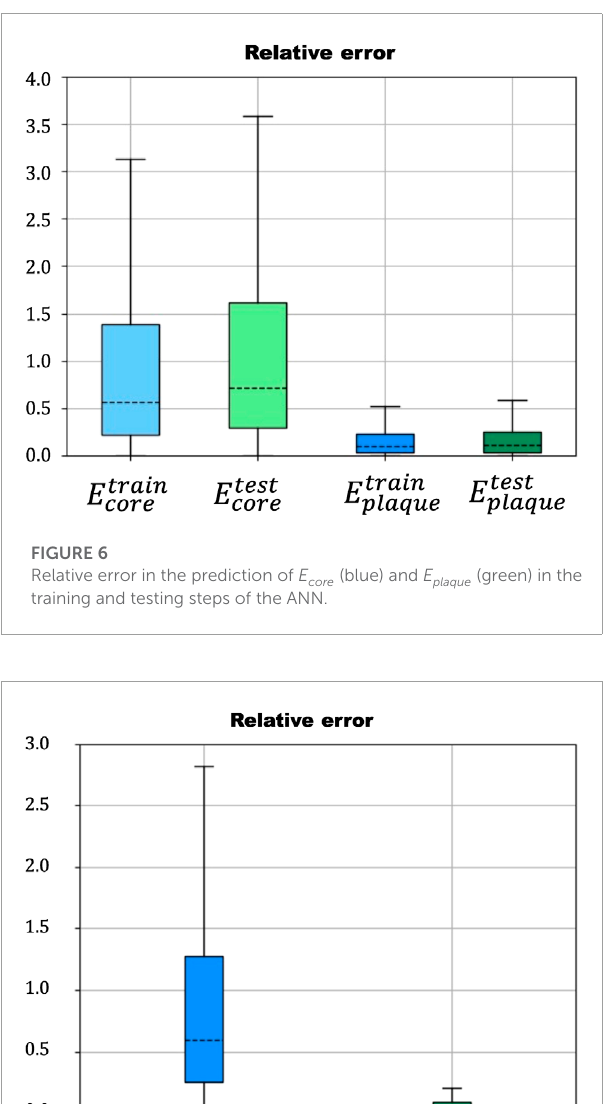
1,000, 1,500, 2000, 3,500, and 5,000. As can be seen in Figure 5 , the loss function (MSE) of this ANN achieves values under 10 –7 .